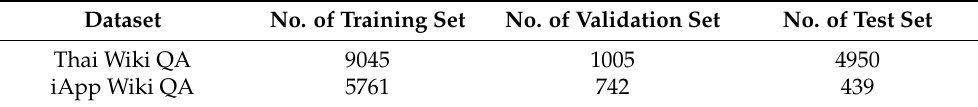
Table 3. Datasets splitting for